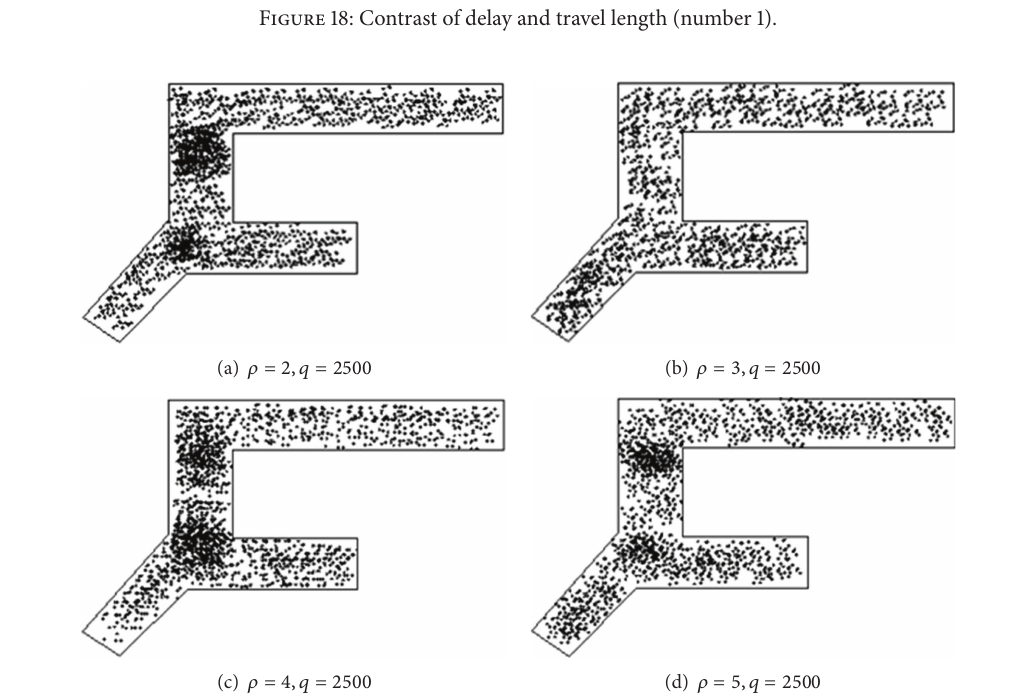
Figure 19: Inner space status sat different intensities (number